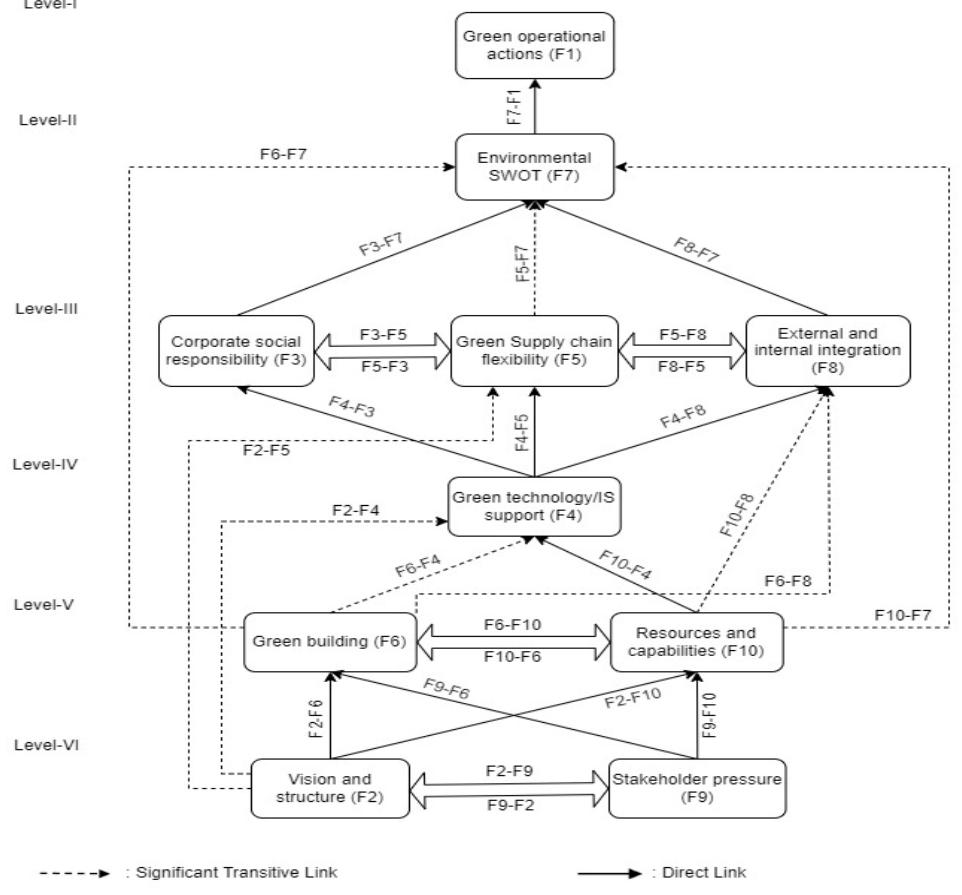
Figure 2. Total interpretative structural model for factors influencing green operations strategies in healthcare. Table 2. Initial reachability matrix factors influencing green operations strategies in healthcare.